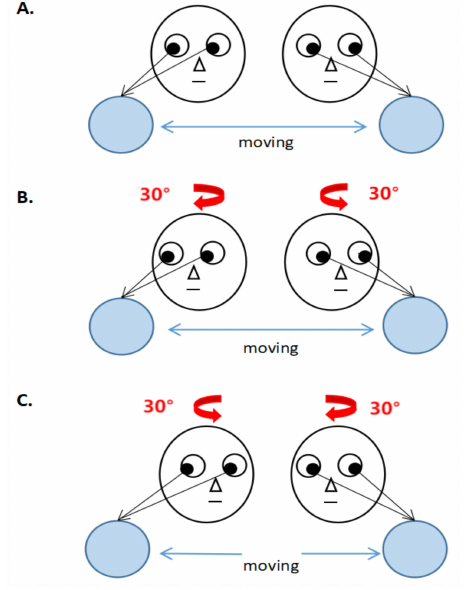
Figure 2. Smooth-pursuit eye movement exercises (( A ): Smooth-pursuit eye movement exercise 1—when standing on one leg, move the target horizontally and track it with the eyes while keeping the head still; ( B ): Smooth-pursuit eye movement 2—when standing on one leg, move the head and target in the same directions horizontally while tracking the target with the eyes; ( C ): Smooth-pursuit eye movement 3—when standing on one leg, move the head and target in the opposite directions horizontally while tracking the target with the eyes.).